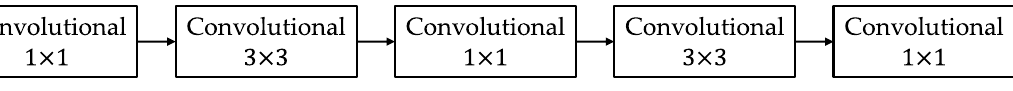
Figure 6. Convolutional set. YOLOV3 [31] predicts a target value for each bounding box using logistic regression.